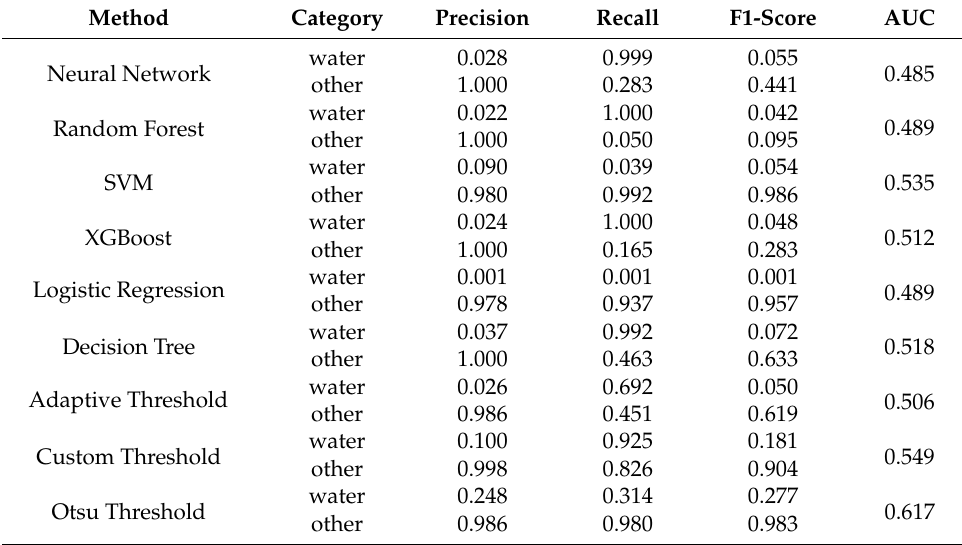
Table A7. Statistics of various indexes of each algorithm in Area2 on October